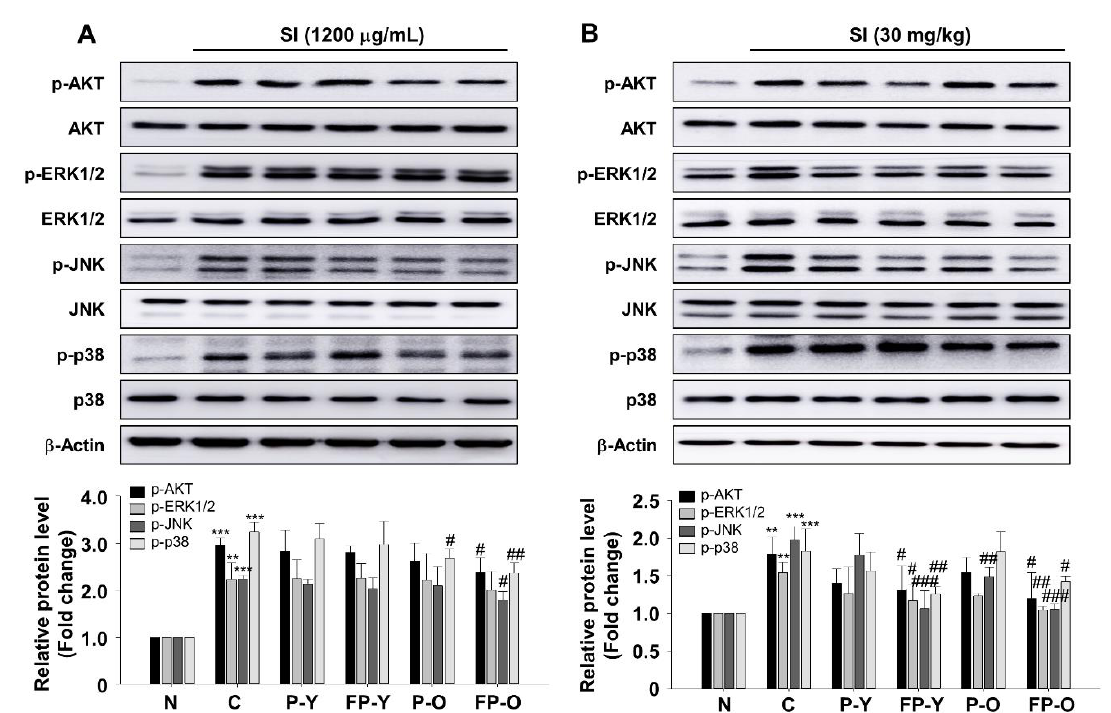
Figure 6. Effect of FP on ultraviolet (UVB)-induced AKT and MAPKs phosphorylation in APRE-19 cells and mouse retina. Representative blot and quantitative analysis of AKT, p-AKT, ERK, p-ERK1/2, JNK, p-JNK, p38, and p-p38 in ( A ) ARPE-19 cells and ( B ) mouse retina. β-Actin was used as a loading control. The band density was normalized using each total protein. Each band was densitometrically quantified by image analysis. ** p < 0.01, *** p < 0.001 vs. N; # p < 0.05, ## p < 0.01, and ### p < 0.001 vs. C. Values are means ± SEM. Significant differences between the groups were determined by ANOVA followed by Duncan’s multiple range test. N, Normal; C, Control; P-Y, Yellow Paprika; P-O, Orange Paprika; FP-Y, Fermented P-Y; FP-O, Fermented P-O.